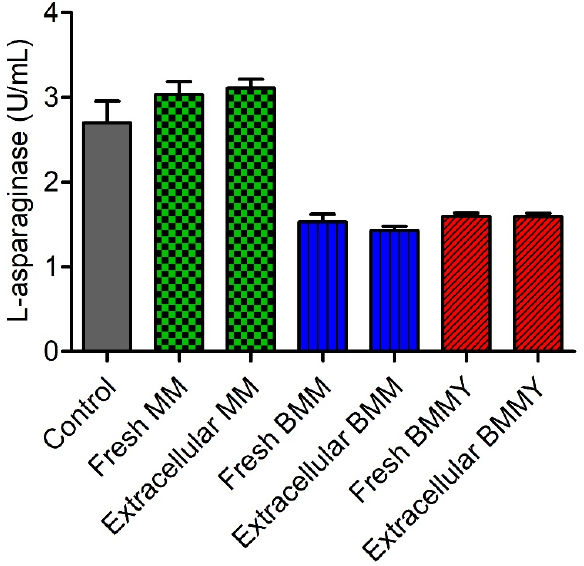
Figure 4. Evaluation of the interference of MM, BMM and BMMY expression media in the quantification of conditioned L ‐ asparaginase activity using the L ‐ aspartyl ‐β‐ hydroxamate acid